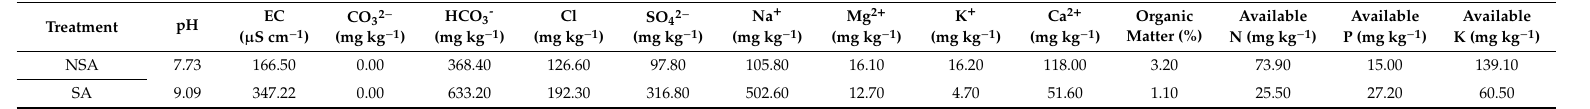
Organic Available